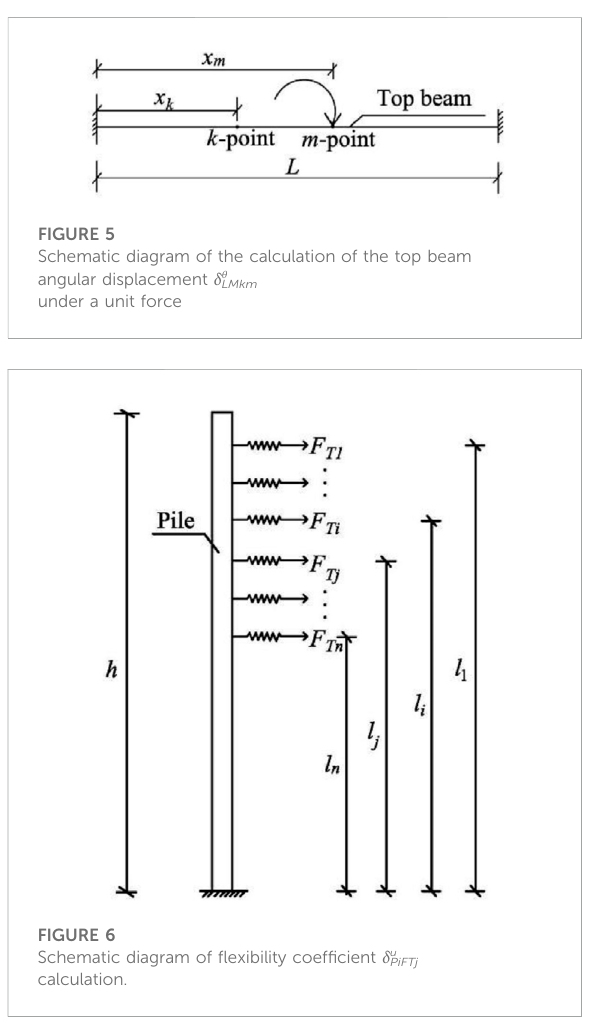
FIGURE 6 Schematic diagram of fl exibility coef fi cient δ u PiFTj